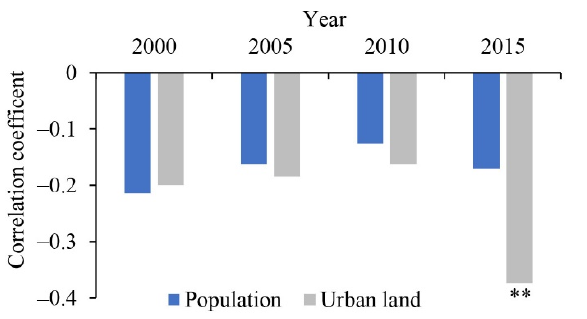
Figure 5. Bivariate correlation between park access and urbanization variables of population density and urban land proportion (** denote the significance of correlation coefficient estimate at the 0.01 level).